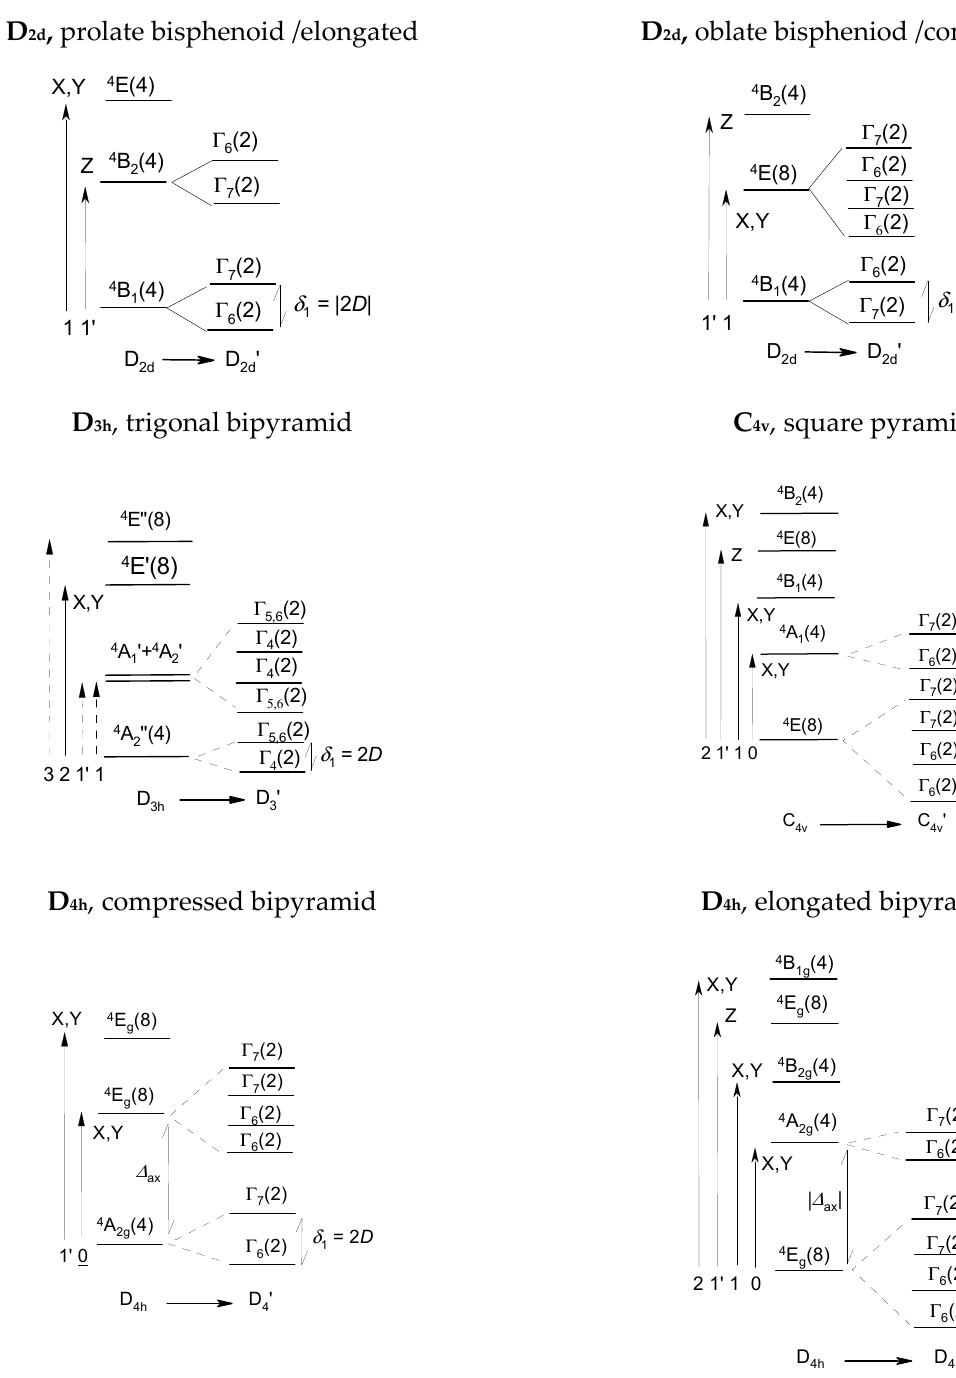
Figure 6. Energy level diagrams for high-spin Co(II) complexes. Crystal field terms are labelled according to the Mulliken notation (A, B, E), the crystal field multiplets according to Bethe ( Γ i ) as irreducible representations of the double group.